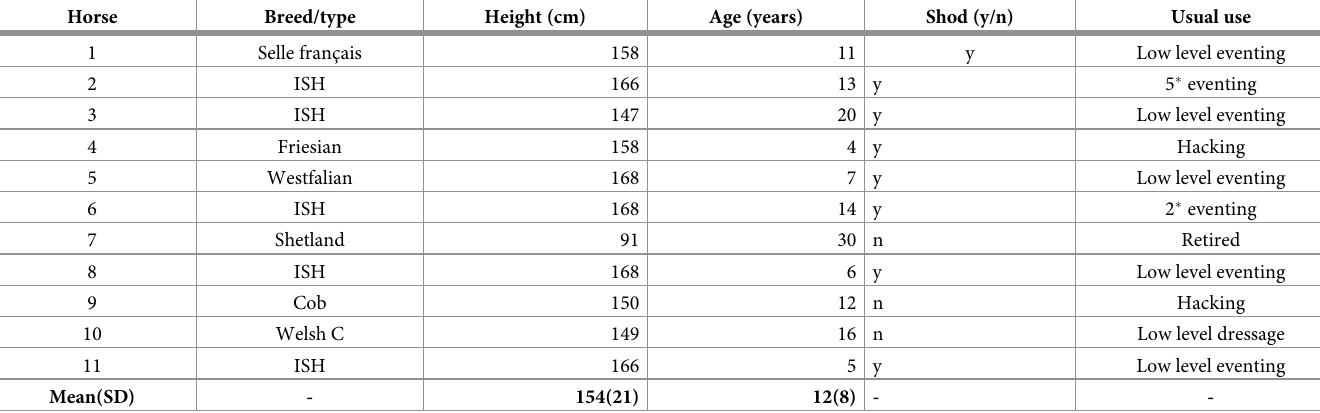
Table 1. Details of subject population.